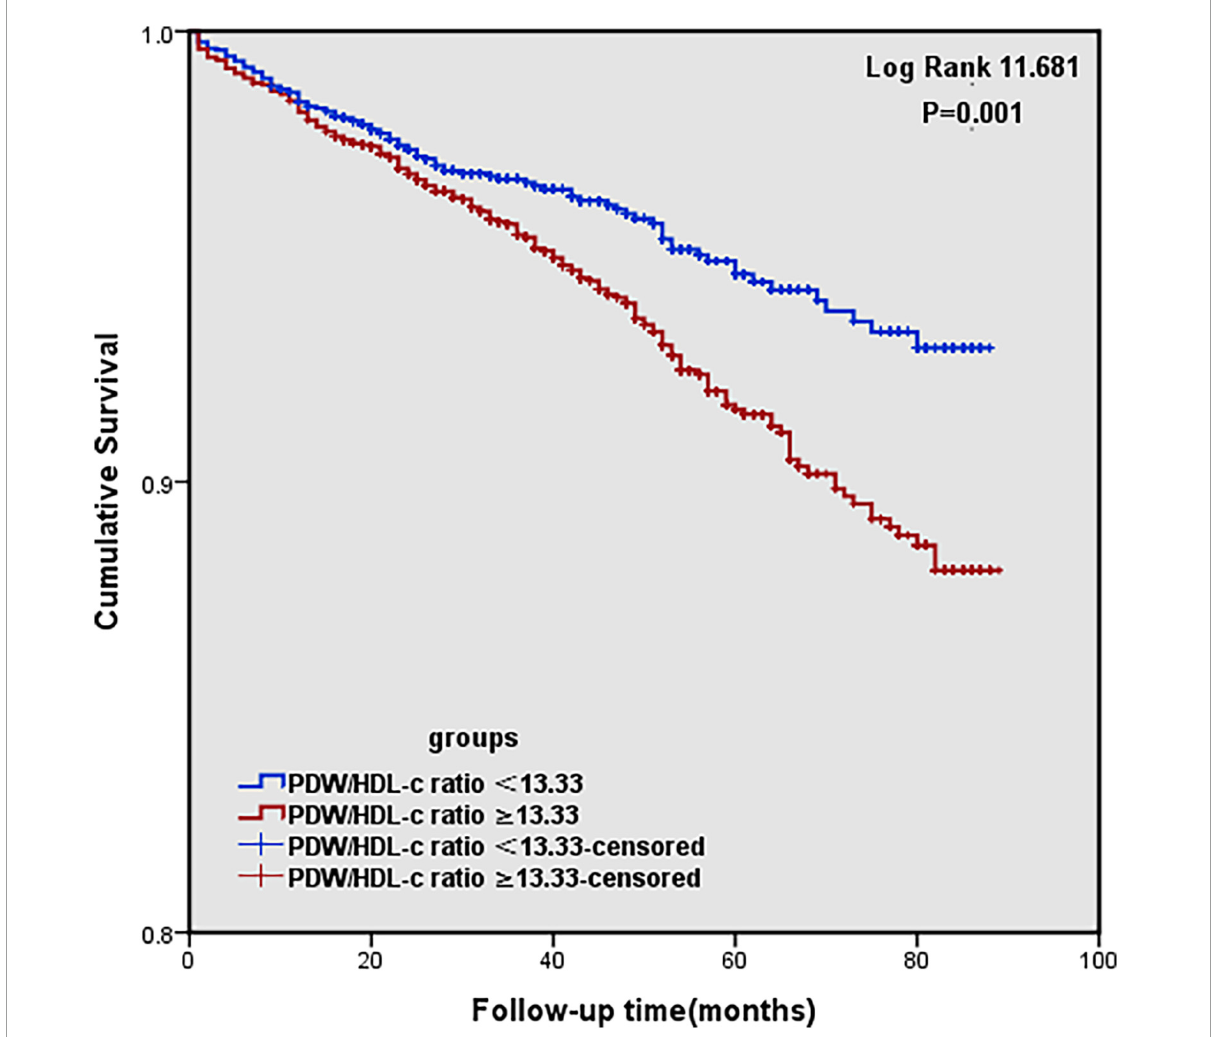
FIGURE2 Kaplan–Meier survival curve for MACCEs (cardiovascular and cerebrovascular events) according to high and low PDW/HDL-C ratio groups.